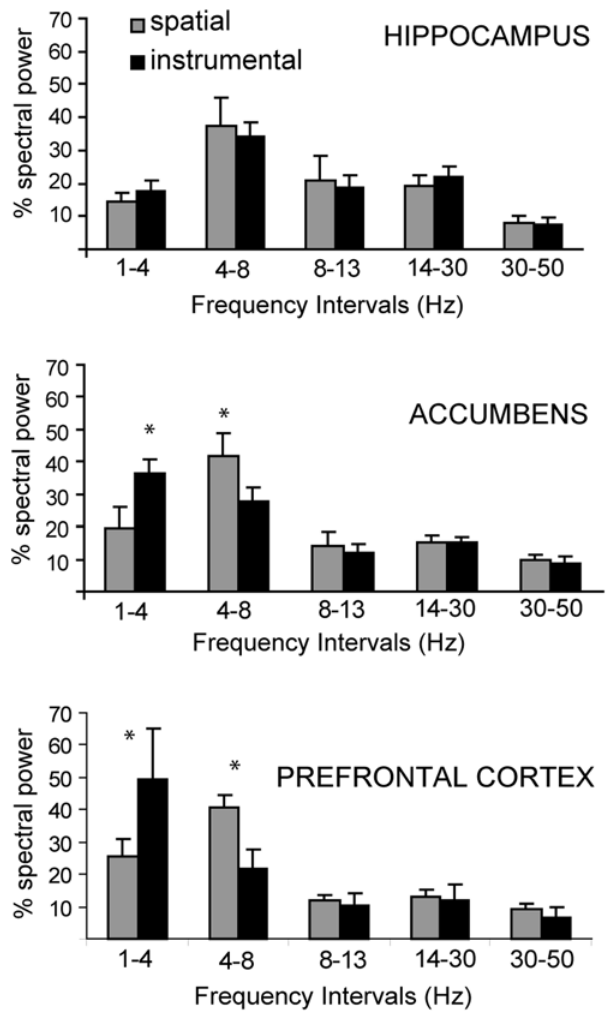
Figure 3. Weight of spectral bands during spatial exploration and goal-directed behavior. Bar graphs depicting summed power for the 1–4 Hz (delta), 4–8 Hz (theta), 8–14 Hz (alpha), 14–30 (beta), and 30–50 (gamma) bands. Gray bars show the weight of each band during spatial exploration and black bars represent band weight during goal- directed behavior. Top to bottom graphs illustrate spectral bands from all accumbens core, hippocampal, and PFC recordings.